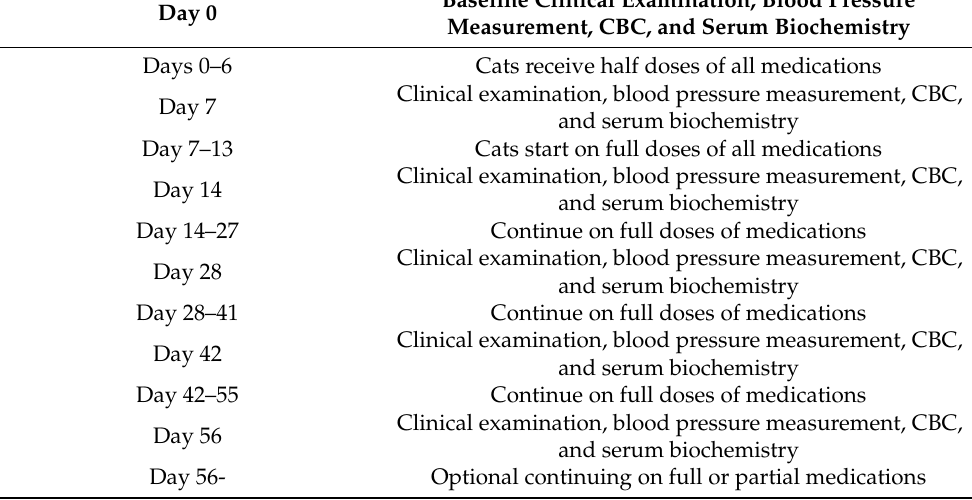
Table 2. Summary of treatments and monitoring throughout the 8-week study. CBC is complete blood count. Baseline Clinical Examination, Blood Day 0